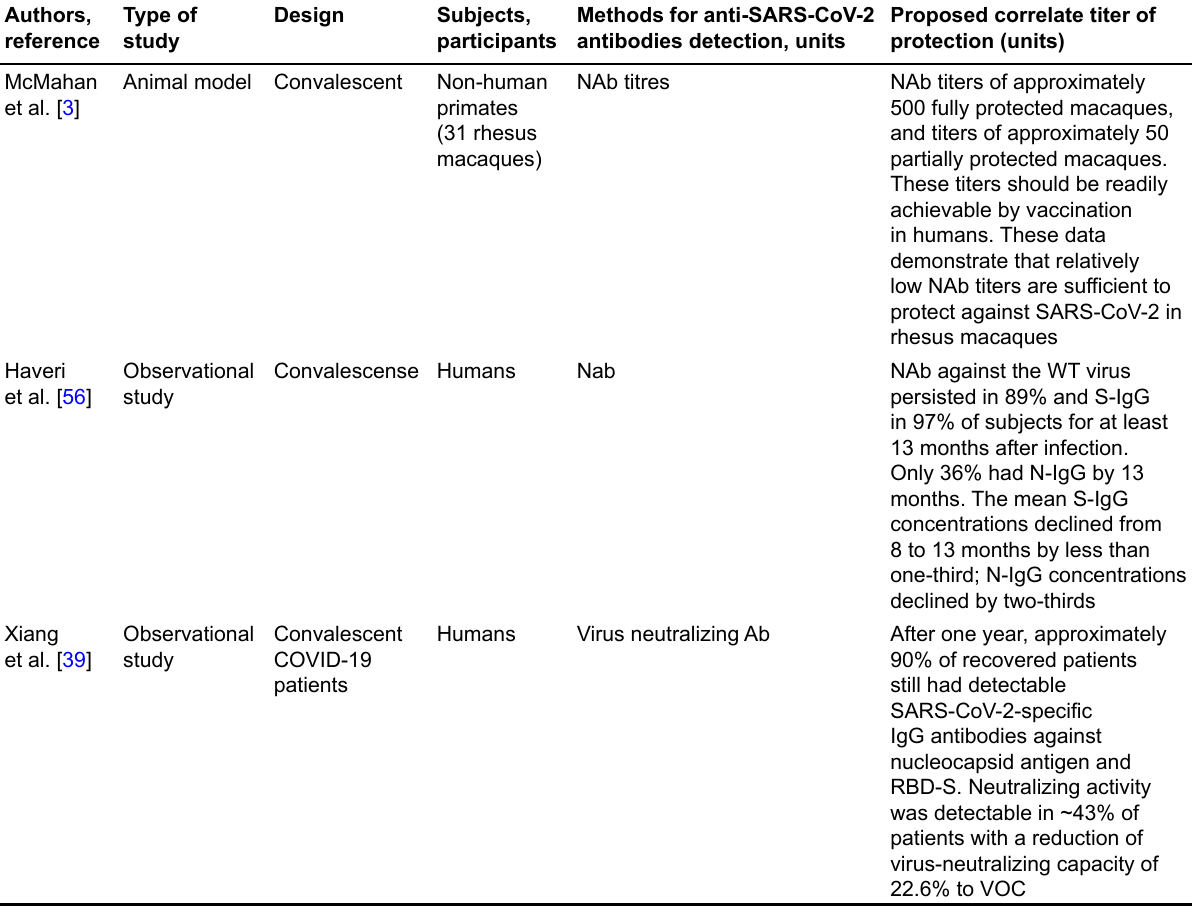
Table 1. Correlates titer of protection against SARS-CoV-2 proposed by different study groups ( continued